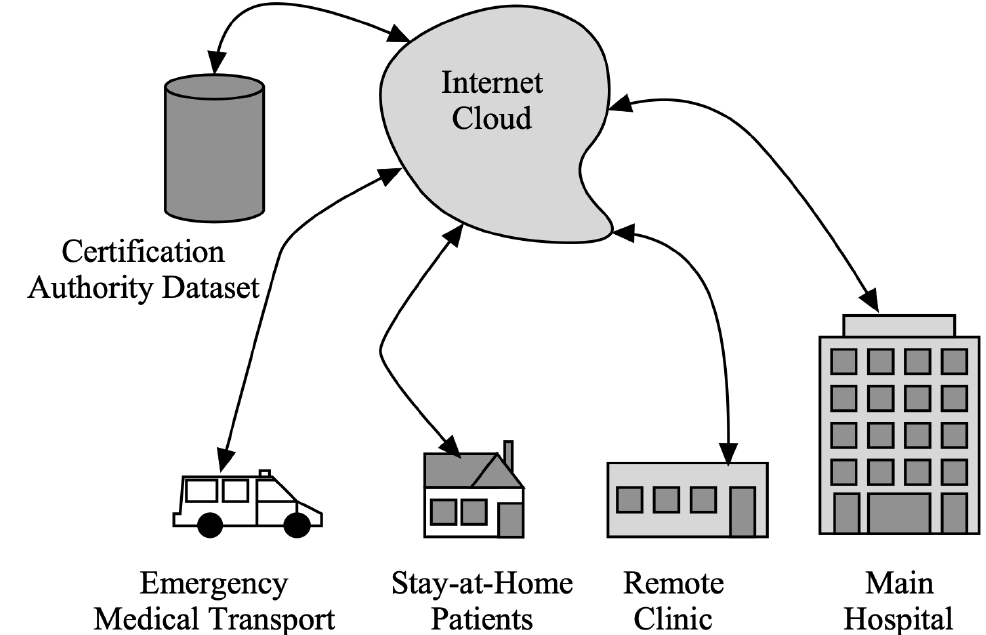
Figure 2. Telehealth system under